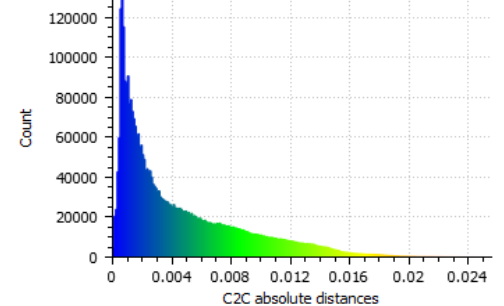
Figure 9. Histogram of distances between the point clouds